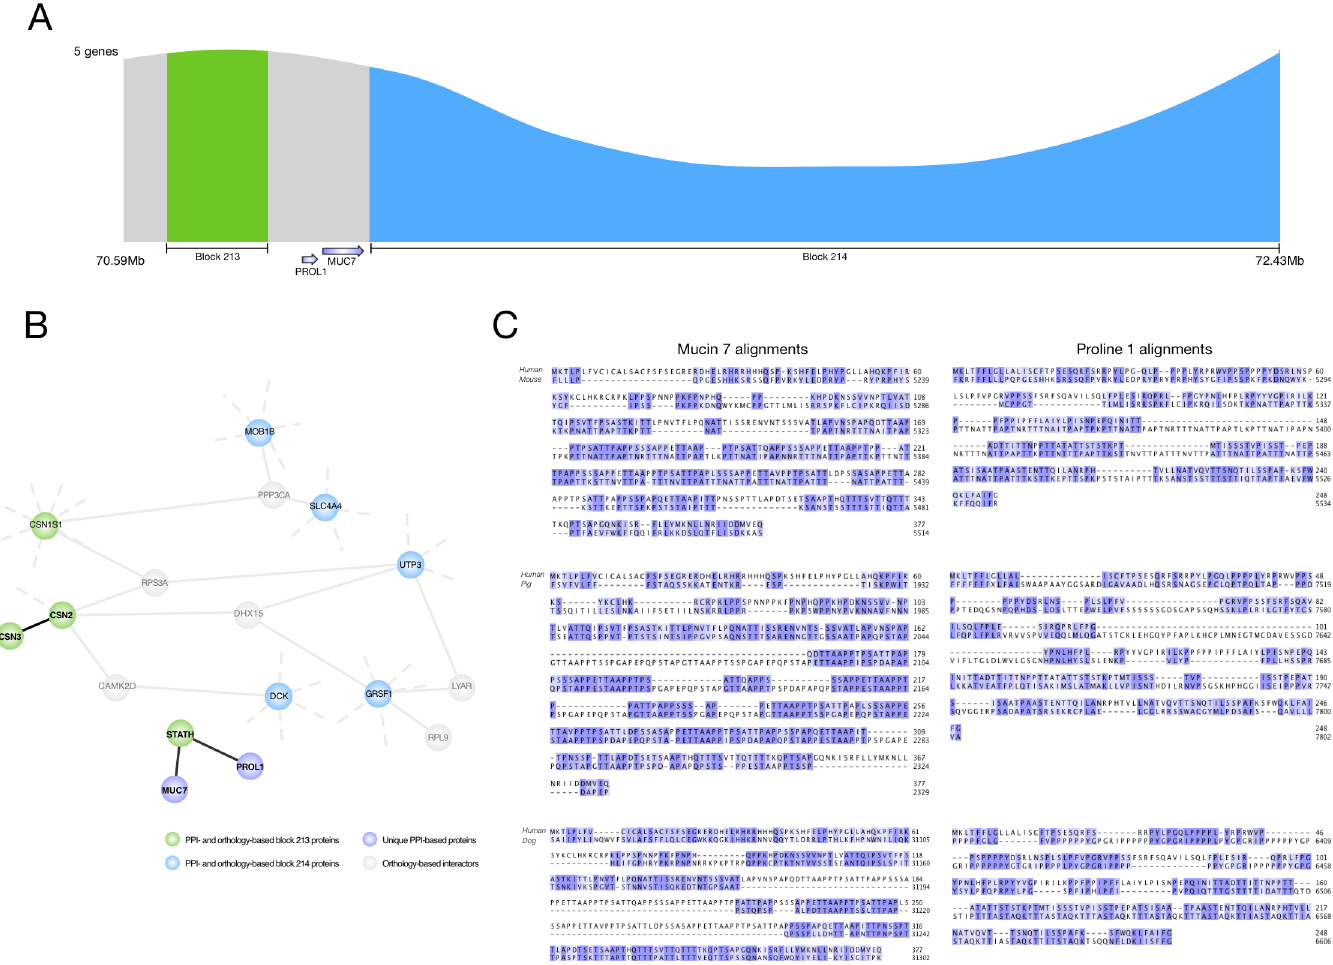
Fig 4. Connectivity-based syntenic blocks can identify protein-coding genes across species. (A) The connectivity-basedblock 442 included orthology-based block 213 (green) and 214 (blue) along with the intermediate regionand an upstream flanking region(both grey). (B) The protein-protein interaction (PPI) network for block 442. The nodes are colored by the location of the protein-coding gene. Purple: uniquefor block 442, green: also in orthology-based block 213, blue: also in orthology-based block 214, and grey: in another connectivity-based block on the same chromosome. Black edges represent PPIs uniquefor block 442. PROL1 and MUC7 make the small network that identified block 442 as syntenic. Their genomiclocationin the intermediate stretch could includeorthologousgenesin the comparedspecies despite not yet being identified.(C) Protein alignmentsof the human PROL1 and MUC7 againstthe translated intermediate block regionin pig, dog and mouse. These alignmentsrevealedsequenceconservation.